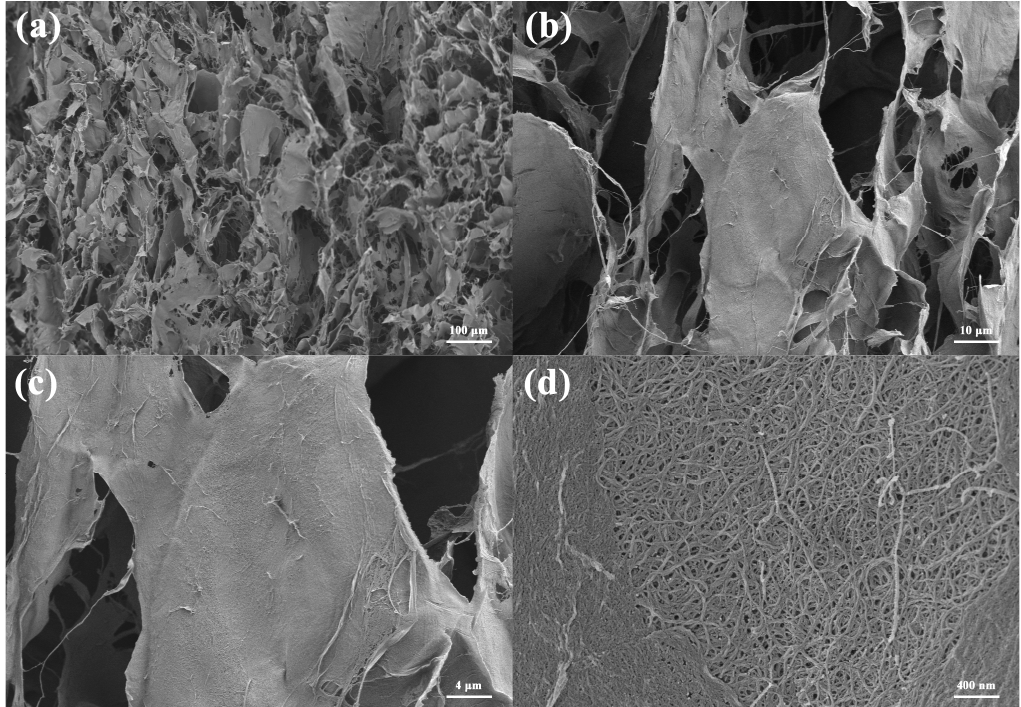
Figure 3. SEM image of CCNF/ANF-5 sample with different magnifications: ( a ) ×100, ( b ) ×1000, ( c ) ×2000, and ( d ) ×20,000.